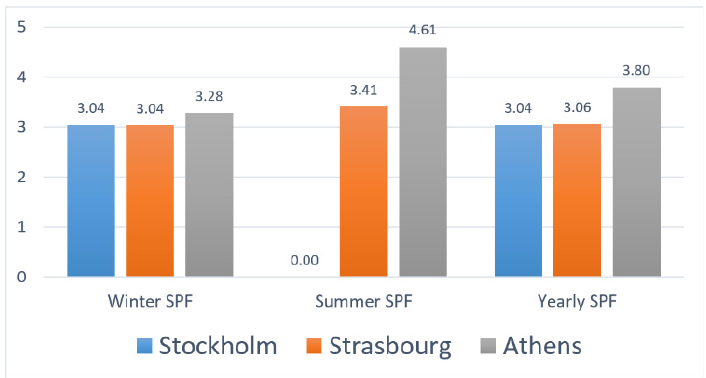
Figure 12. Winter, summer, and yearly SPF in three analyzed cities (15th year of operation).